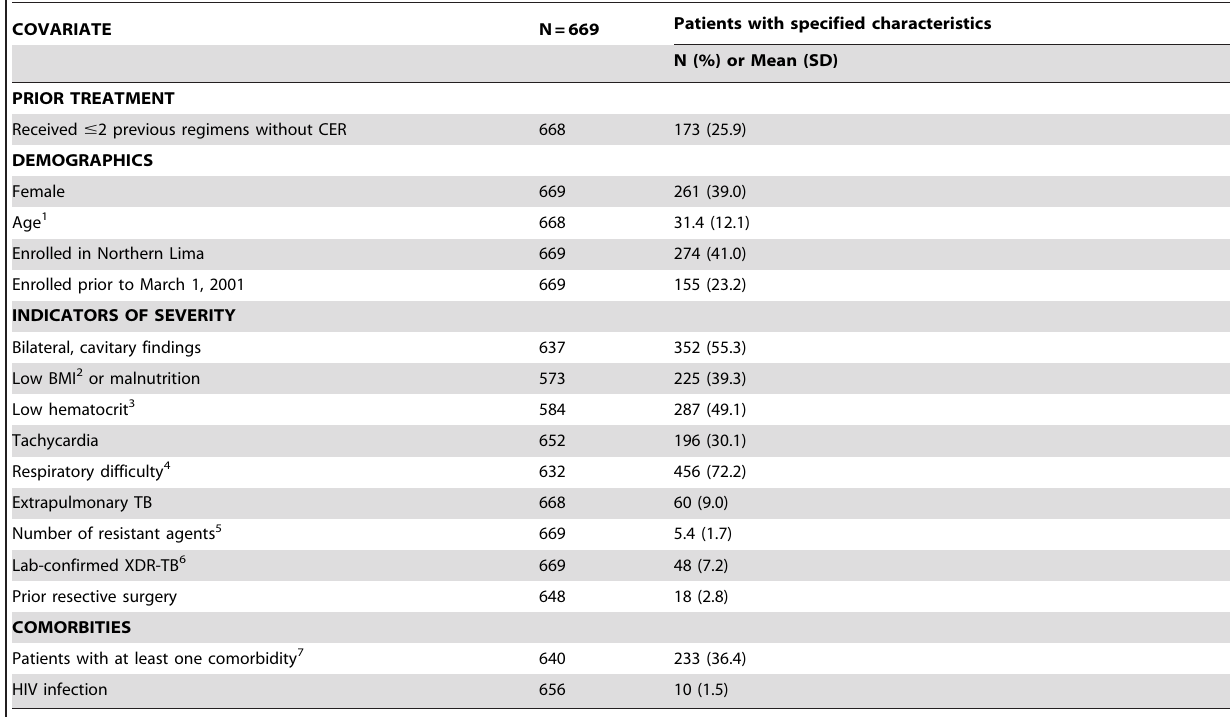
COVARIATE N=669